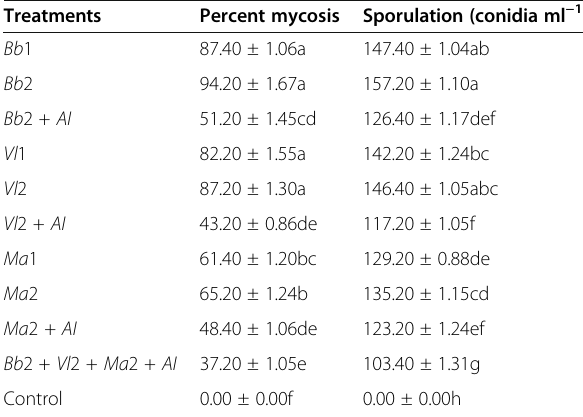
Table 2 Percent mycosis and sporulation (conidia ml − 1 ) (mean ± SE, n = 5) from dead cadavers of 2 nd instar Pectinophora gossypiella larvae due to the highest concentrations of Beauveria bassiana , Verticillium lecanii , Metarhizium anisopliae (1 × 10 8 conidia ml − 1 ) (alone and in combination). Means sharing with same lower case letters are not significantly different from each other at 0.05 level of significance, i.e., P < 0.05